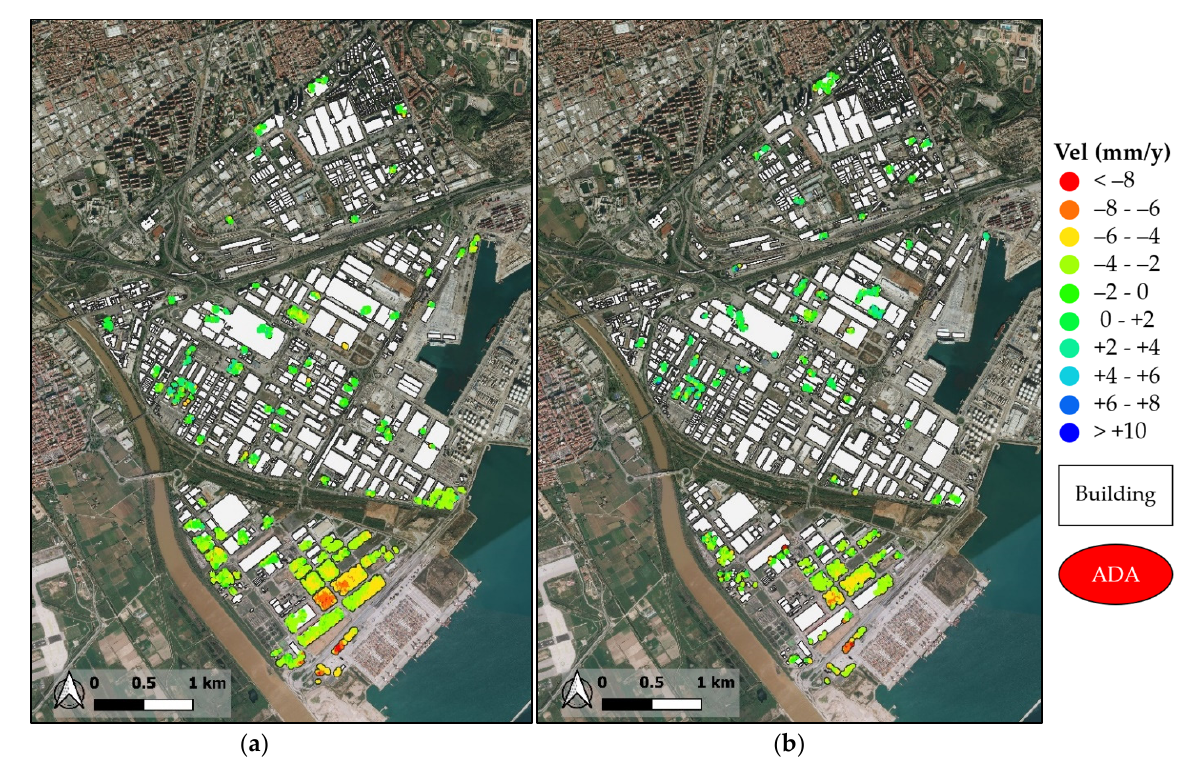
Figure 5. ADA extraction from the active PSs of the selected area of Zona Franca from ( a ) ascending and ( b ) descending datasets. Table 4. Statistics of the mean velocity V m (mm/y) of the active PSs of the selected area of Eixample .